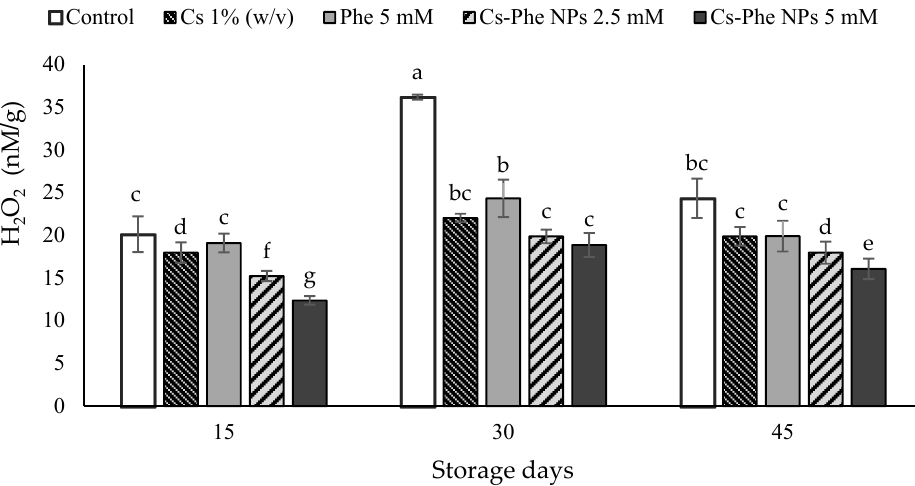
Figure 4. Effects of chitosan, phenylalanine, and chitosan-coated phenylalanine nanoparticles treatments on the H 2 O 2 content of persimmon fruit during storage at 4 °C for 15, 30, and 45 days. Each value represents the mean ± standard errors of three replications. Different letters indicate statistical differences using Duncan’s multiple range tests at P < 0.05 level.